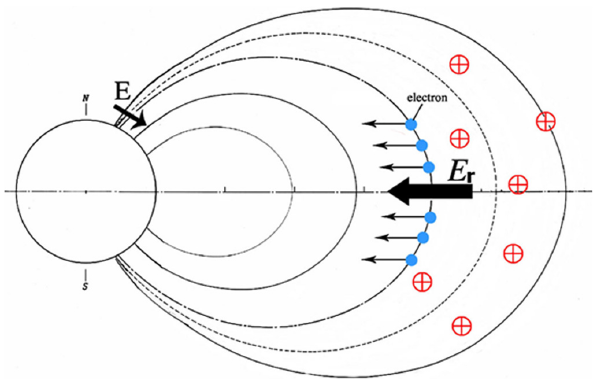
Fig. 16. Schematic illustration of how the earthward electric field E r can be produced when the cross-tail current is reduced (Aka- sofu, 2007, p.